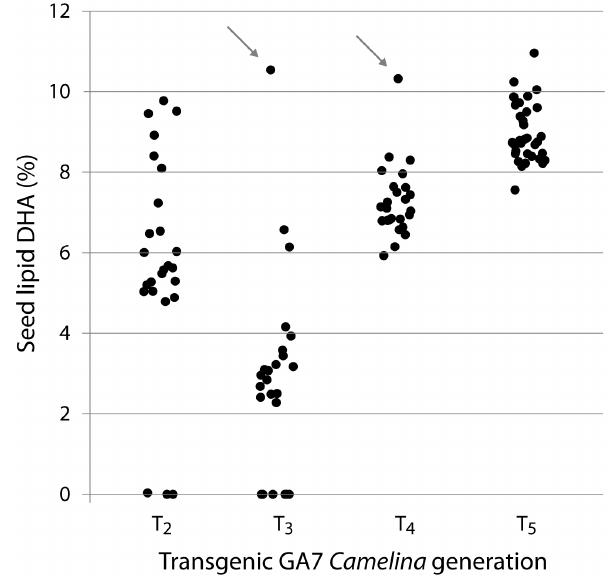
Figure 5. Relative level of DHA (as % of total fatty acids) in four generations of a transgenic multi-copy GA7 Camelina sativa line. The T 2 generation shows single seed DHA levels, whilst pooled seed results (20 seeds per batch) are shown for T 3–5 (T 4 and T 5 are not segregating). Arrows denote lines which were progressed to form the next generation.